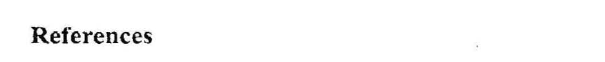
Figure 3. Mean serum concentrations of neopterin in ::onnal individuals and CRP-positive and CRP-nega :l\e patients with renal cell carcinoma. Values are ~xpressed as mean ± SD.